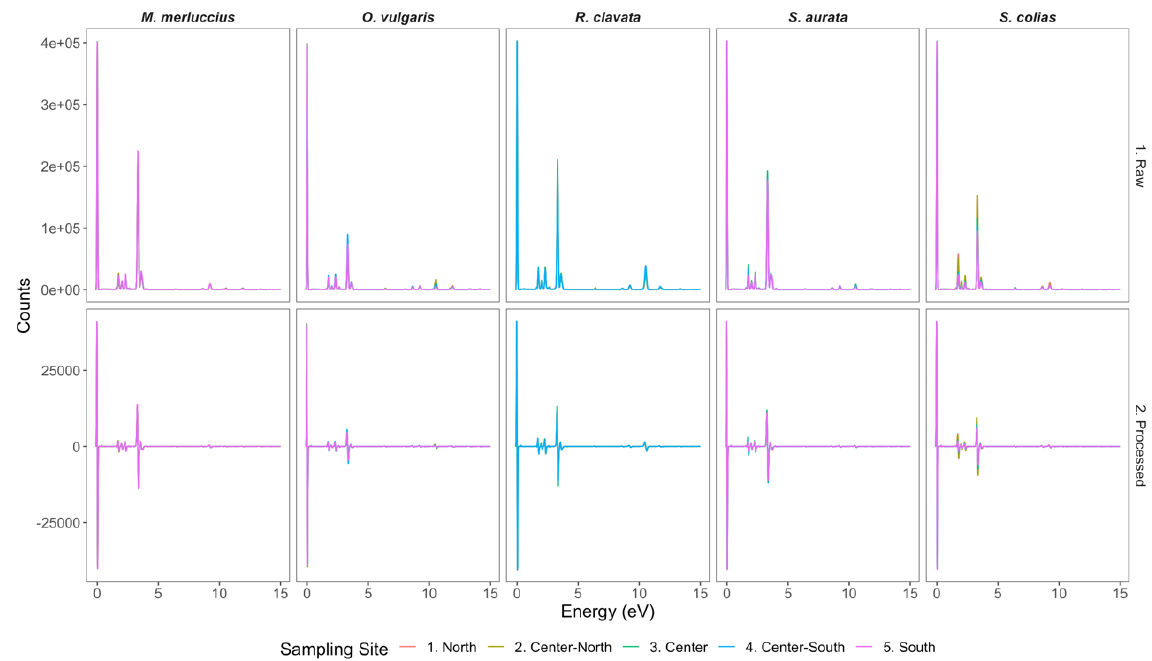
Figure 2. Average raw (upper panel) and processed (lower panel; Savitzky–Golay filter with the first-order differentiation) X-ray fluorescence reflectance spectra of the Merluccius merluccius , Octopus vulgaris , Raja clavata , Sparus aurata , and Scomber colias samples collected in 5 areas along the Portuguese coast (N = 30 per site per species, except for R. clavata in center-south area).